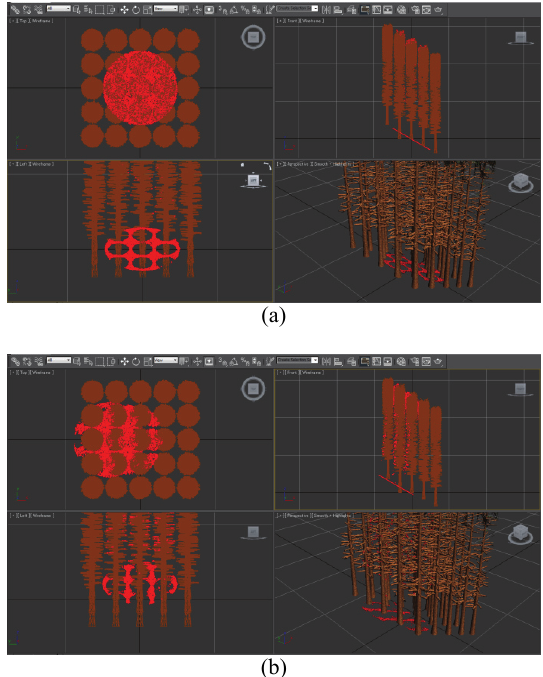
Figure 4. The results of visualization of intersections derived from scenario no.2 (a) and no.5